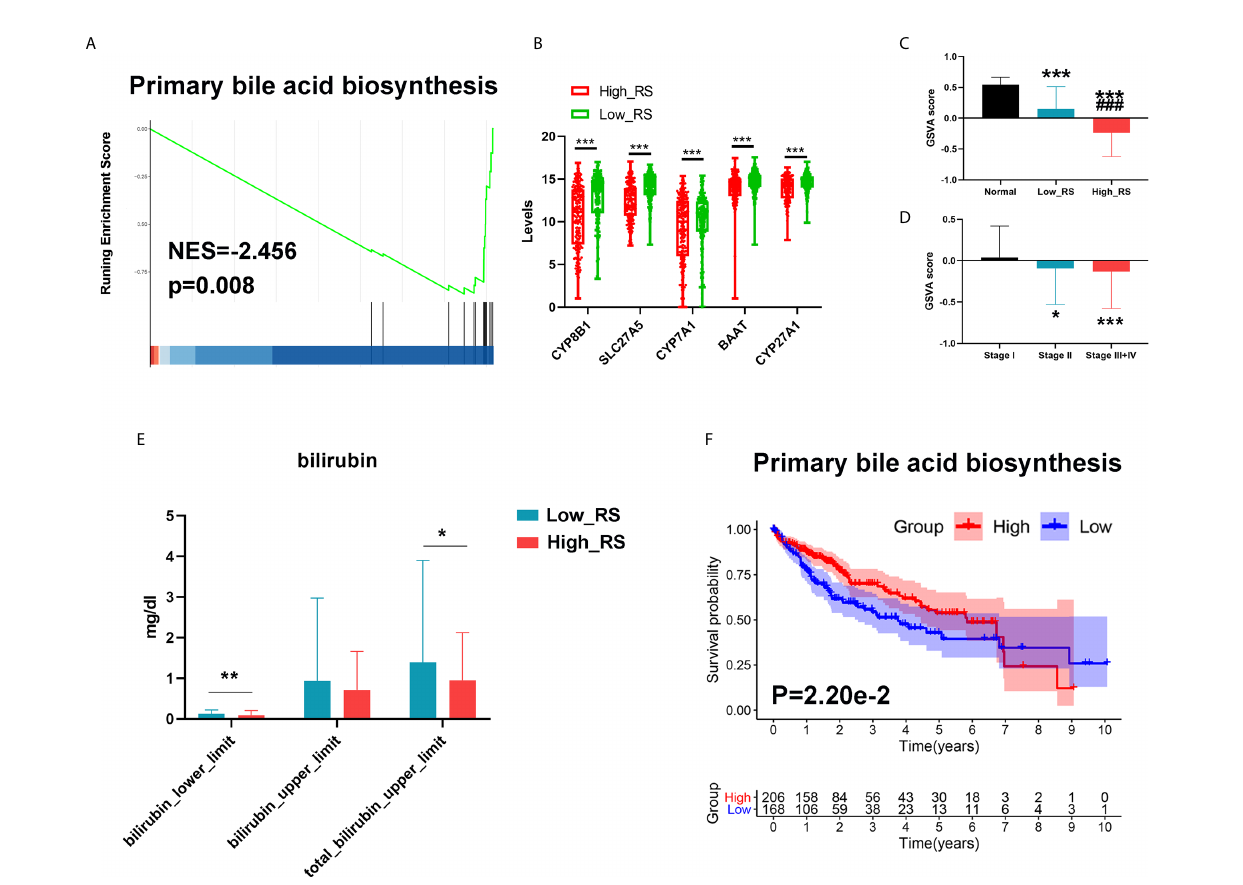
FIGURE 7 | Changes in primary bile acid metabolic processes between high- and low-risk HCC. (A) The primary bile acid biosynthesis pathway was signi fi cantly enriched in low-risk HCC as revealed by GSEA analysis. (B) Top 5 downregulated genes of the primary bile acid biosynthesis pathway in high-risk HCC samples. (C) The primary bile acid biosynthesis pathway was signi fi cantly downregulated in high-risk HCC compared with low-risk HCC and normal liver tissues as revealed by GSVA analysis. *** P < 0.001 vs normal group; ### P < 0.001 vs Low risk score. (D) The primary bile acid biosynthesis pathway was signi fi cantly downregulated in stage III+IV compared with stage II and stage I HCC as revealed by GSVA analysis. (E) The levels of bilirubin between low- and high-risk HCC. (F) Kaplan – Meier survival analysis of the prognostic value of altered metabolic pathways in HCC. GSVA score = 0 was set as the threshold value. * P < 0.05, *** P < 0.001 vs stage